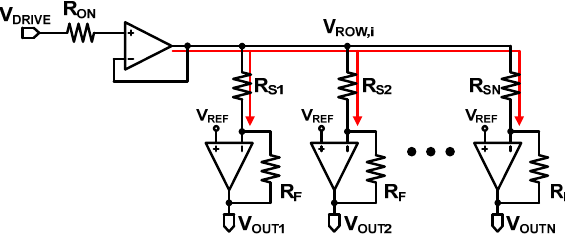
Figure 6. Equivalent circuit model of a resistive sensor array with row driver Type II.